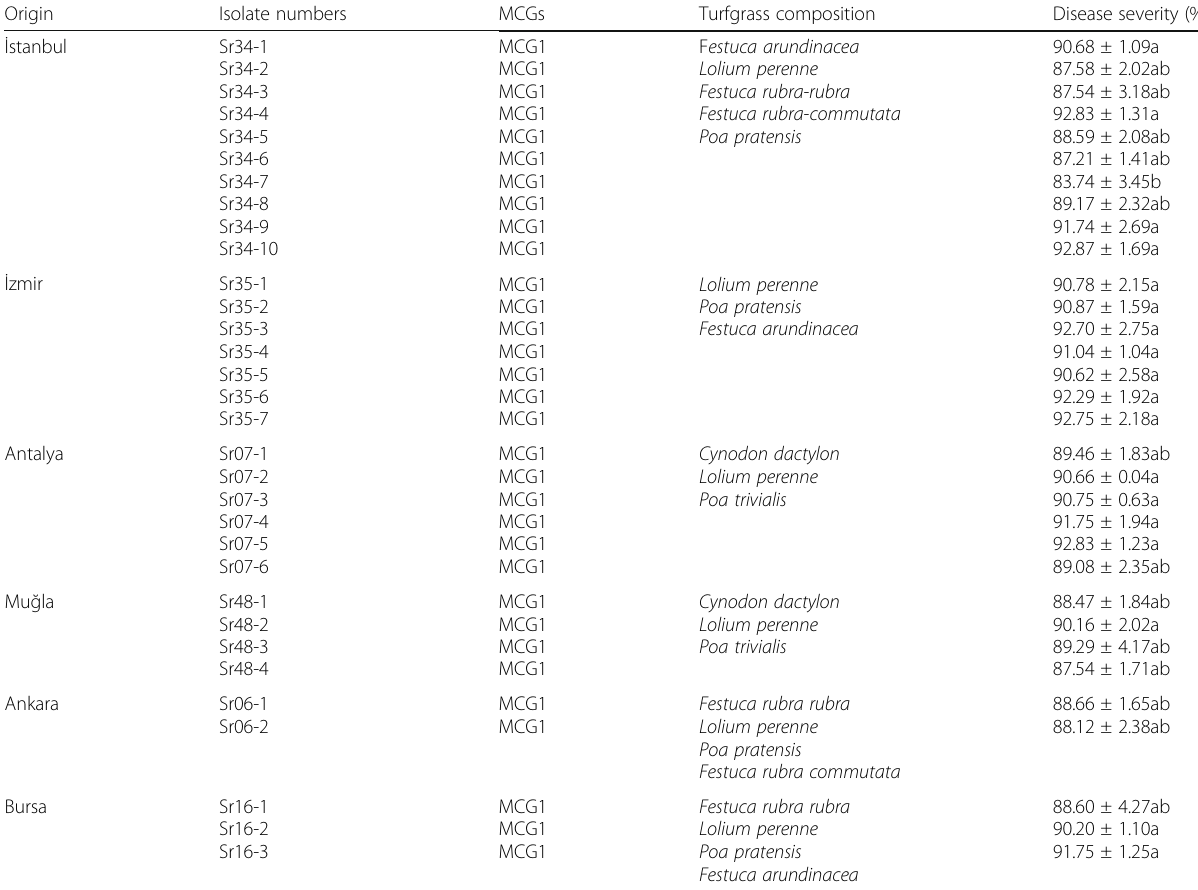
Table 1 Origin, number, MCGs, and disease severity values of Sclerotium rolfsii isolates isolated from turfgrass